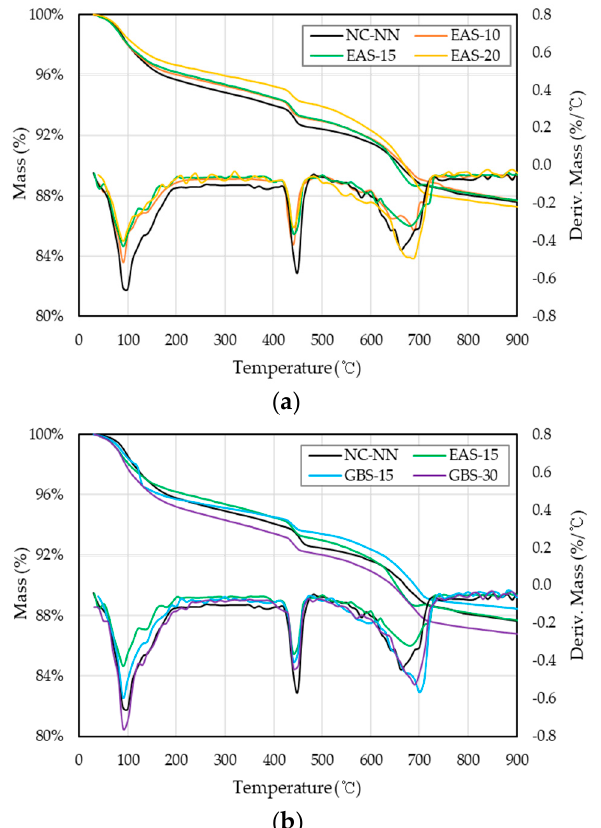
Figure 3. TG and DTG curves for HSC mixtures: ( a ) comparison of EAS replacement ratios; ( b ) comparison of EAS and GBS.